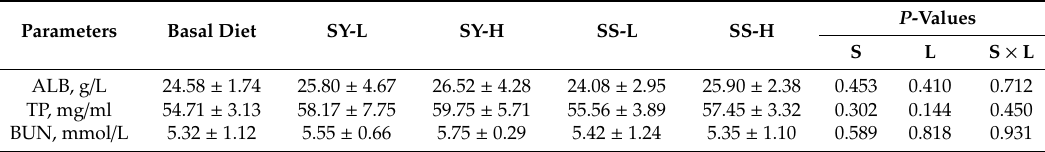
Table 5. E ff ects of dietary supplementation of di ff erent selenium sources and levels on serum biochemical indexes of laying